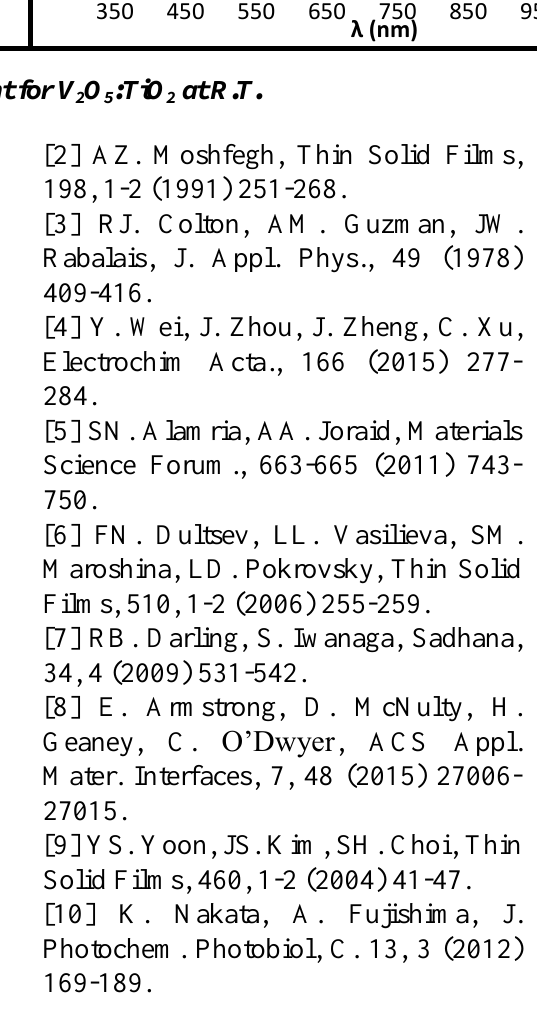
Fig. 7: Optical constant for V